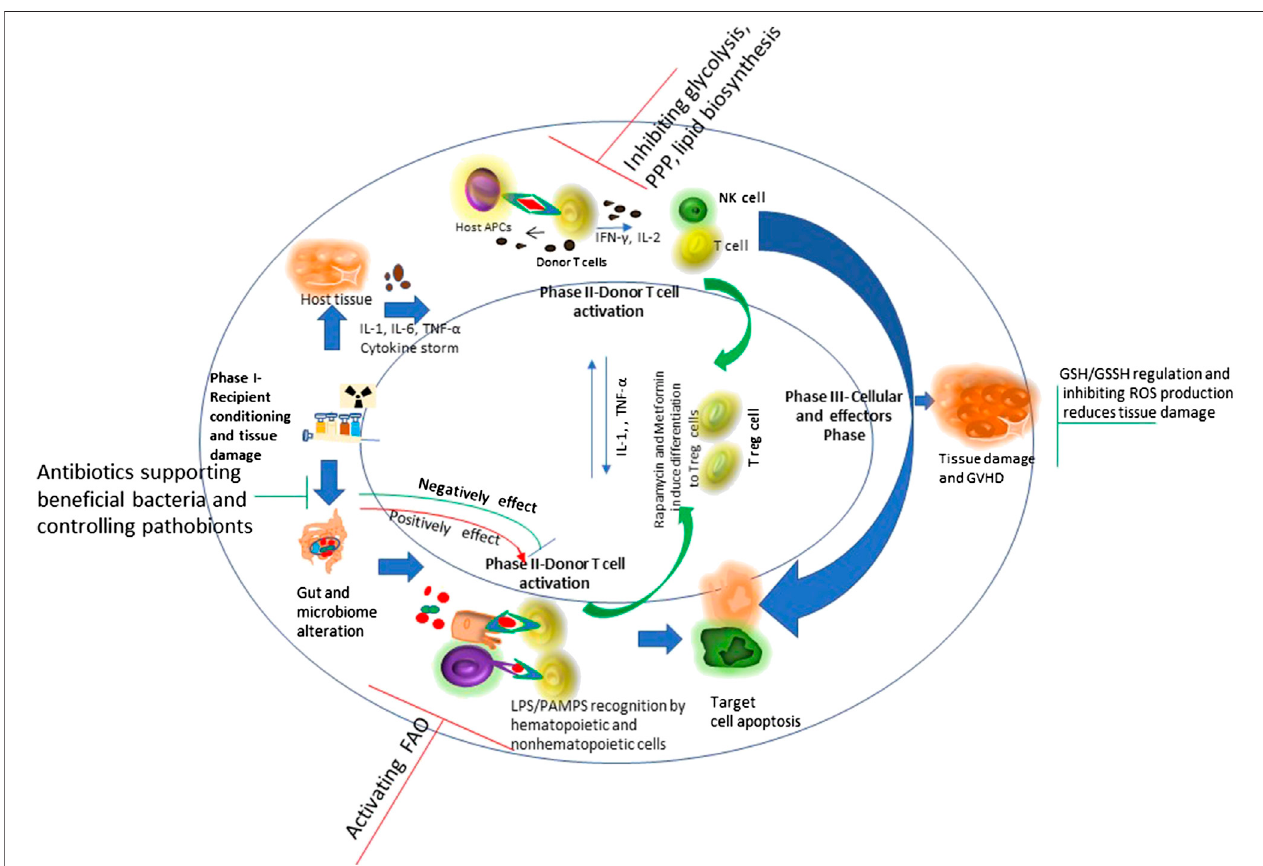
FIGURE 2 | Schematic overview of graft vs. host disease (GVHD) pathophysiology with immunoregulatory aspects: Conditioning regimen at the time of transplant causesdamagetothehosttissues.Thisleadssecretionofpro-in fl ammatory cytokinesliketumor necrosisfactorinterleukin-6and interleukin-1. Thesepro-in fl ammatory cytokinesinduceantigenpresentingcellactivation.ConditioningregimenalsodisturbsthehomeostasisatintestinalmucosalFrontierduetodamagecausedtoepithelial barrier injury and the microbiome niche. This causes increased movement of bacteria, MAMPs (microbe-associated molecular patterns), and polysaccharides to themucosa.Thisconsistphase-IofGVHDdevelopment.Duringphase2,activatedantigenpresentingcellsinduceTcellmaturationandproliferation.TheeffectorTcells and an in fl ammatory cytokine storm together affect the host tissue causing further damage and perpetuating the cycle that aggravates GVHD, considering phase III. Figure modi fi ed from (Ferrara et al., 2009) Lancet 2009; 373: 1,550 – 61.